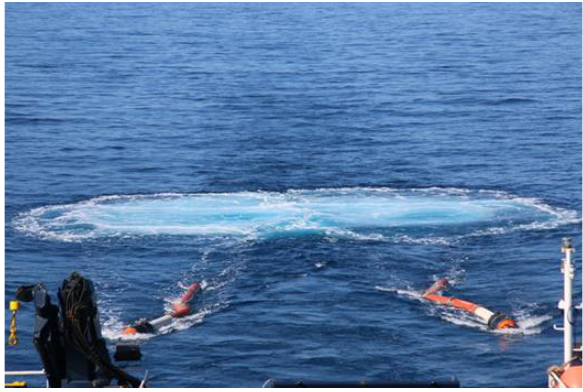
Figure 10. A picture of the real bubble generated by the air-guns mounted in the vessel “Sarmiento de